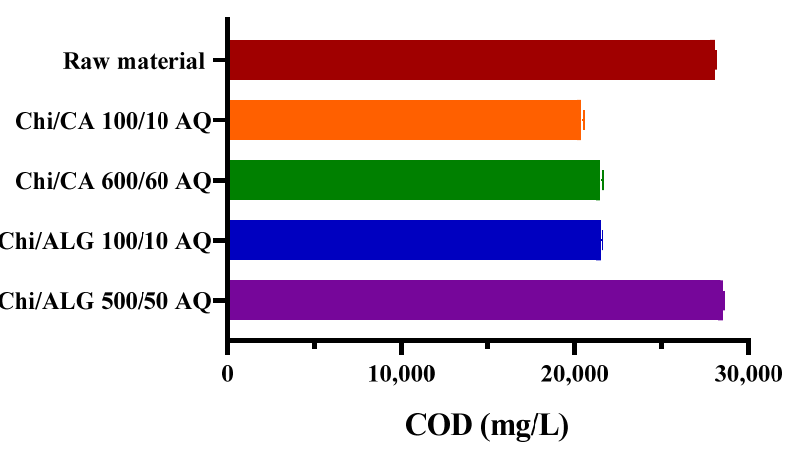
Figure 9. Effect of the coagulation/flocculation process on the COD levels of the supernatants. Note: Legislation allows for effluent discharge for COD values < 2000 mg/L O 2 .